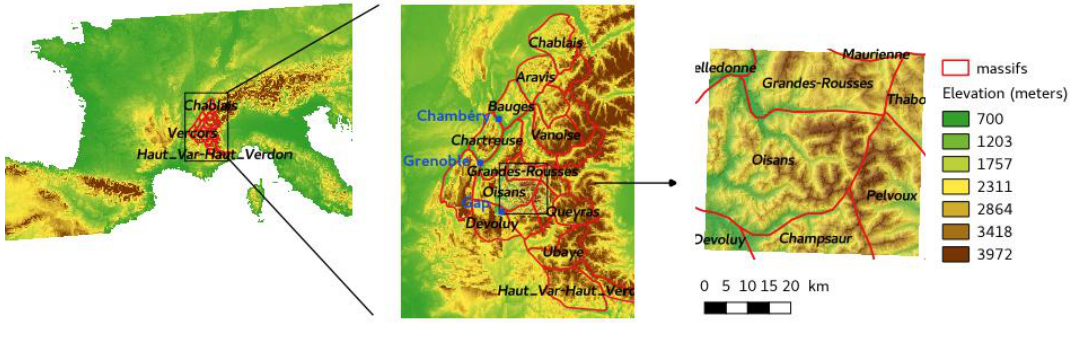
Figure 1. Topography of the study area located in Europe, France, Northern French Alps. The mountainous regions concerned are the Oisans, Grandes-Rousses, Pelvoux, Champsaur, Thabor, Devoluy, Belledonne and